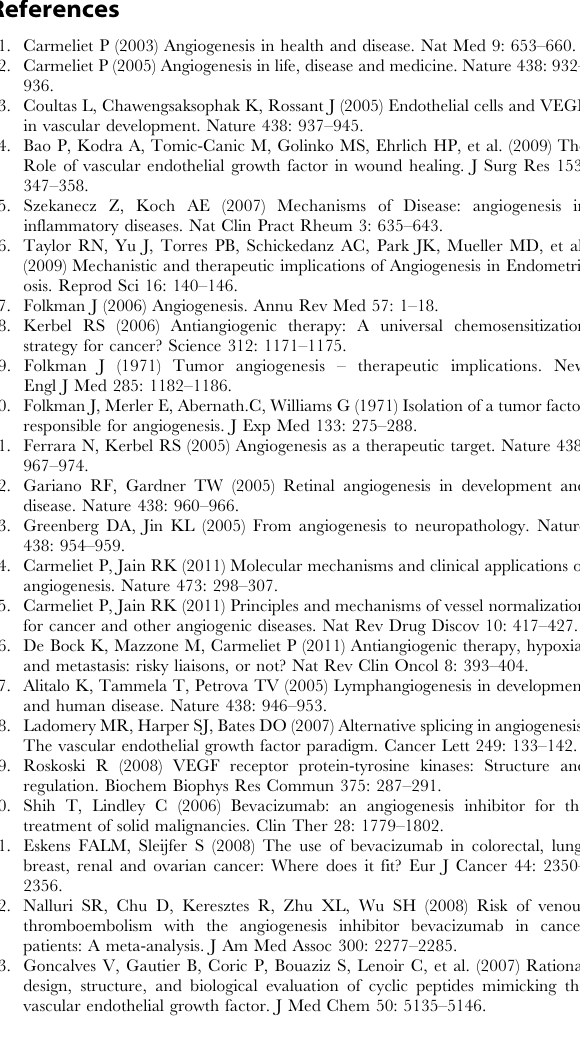
Table S1 Full assignment of the NMR spectral data obtained for compound